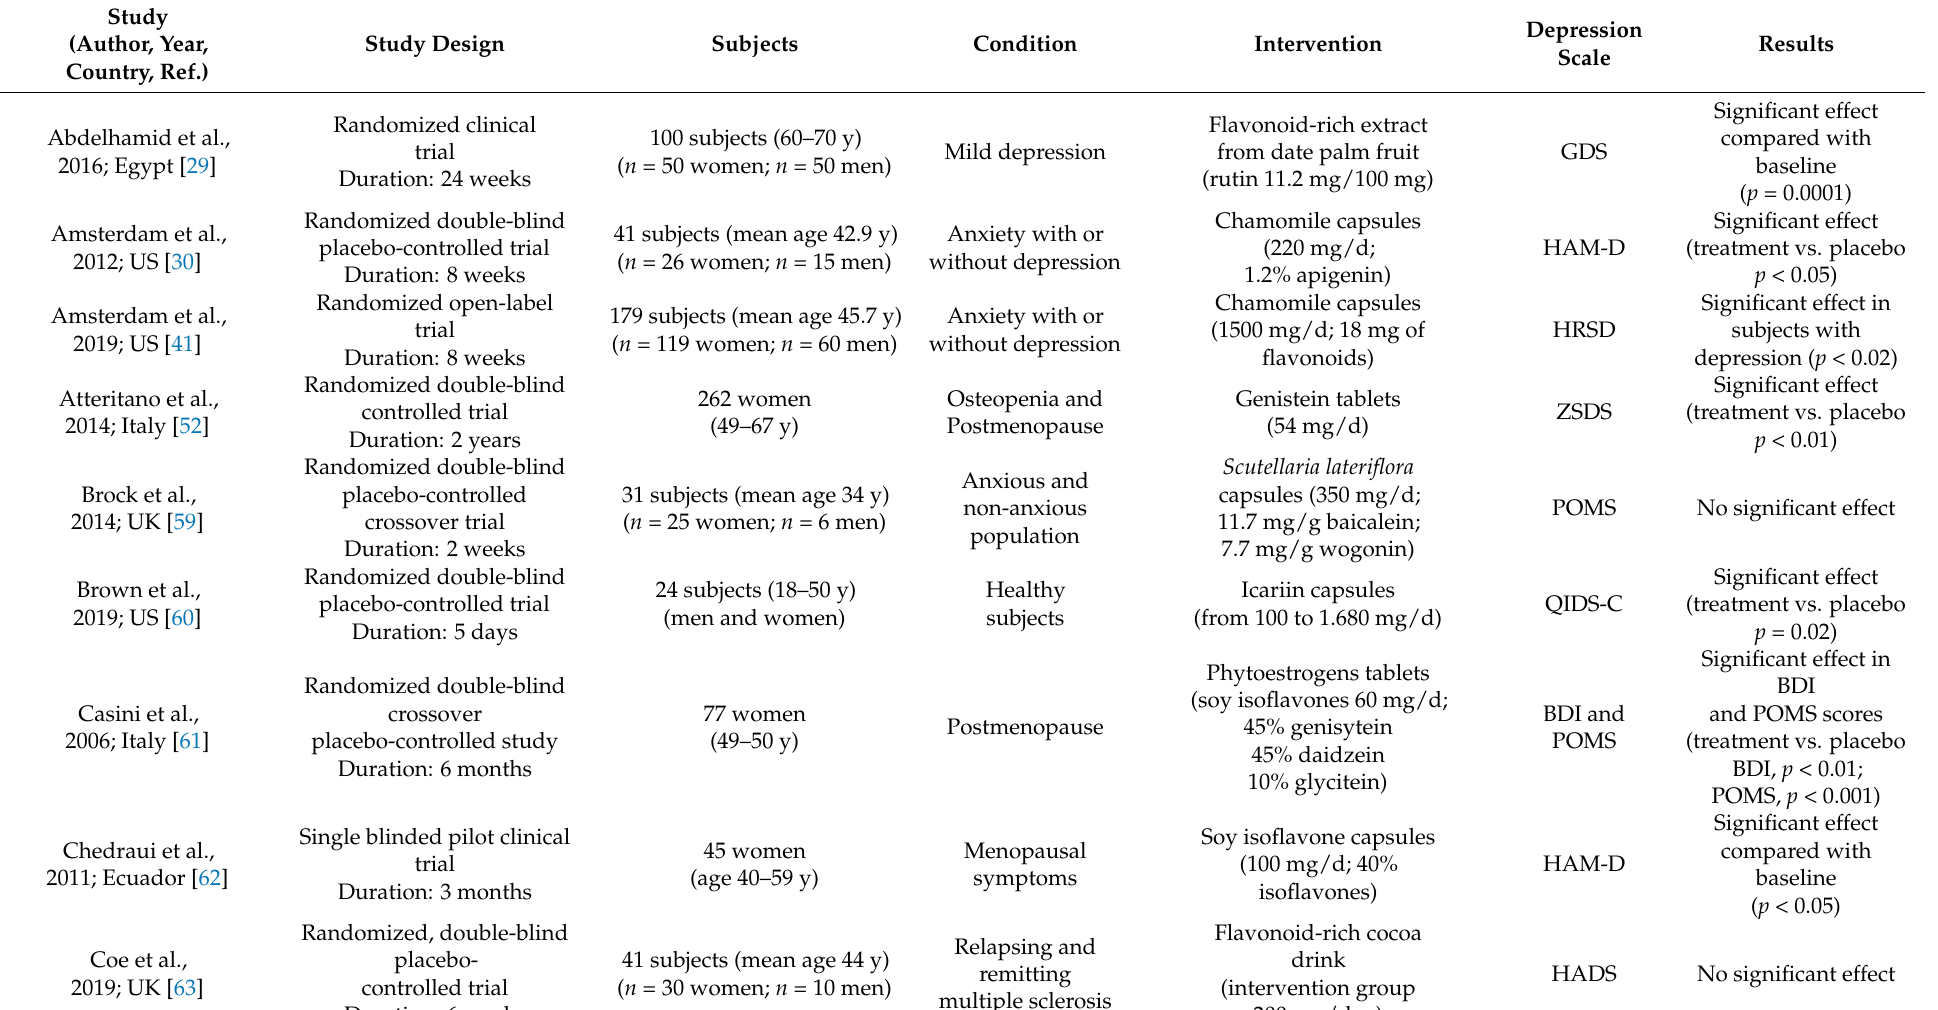
Table 1. Data summary of clinical intervention trials assessing the effects of flavonoids on depressive